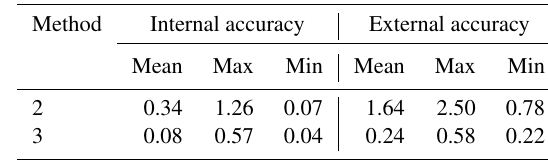
Table 2. Statistical result of RMS error for the old/new unit scale factor models used by the conventional and improved methods in the experiment (gm − 3 )